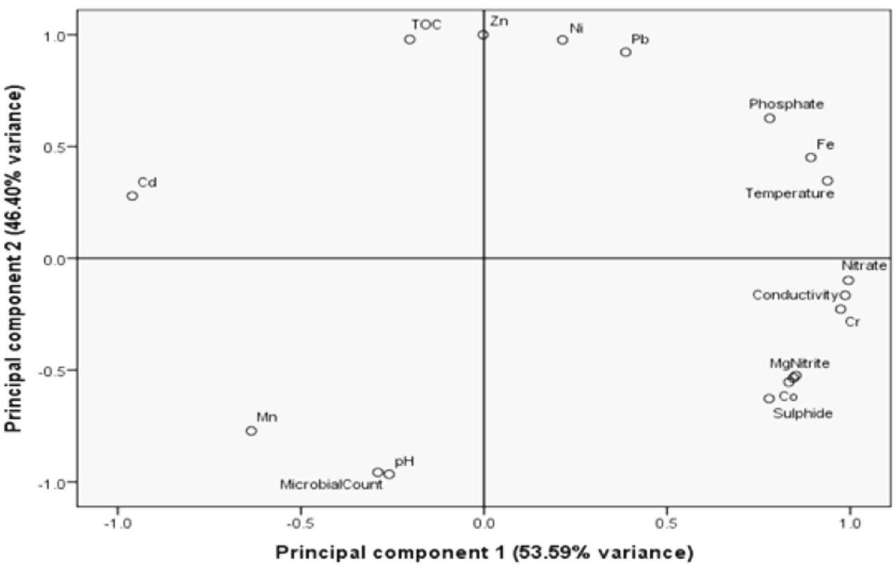
Fig. 4 Principal component analysis of physico-chemical parameters and microbial count in